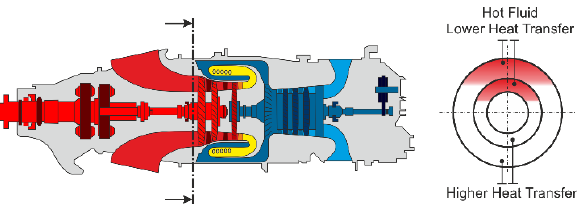
Fig. 1. Solving area of turboprop engine